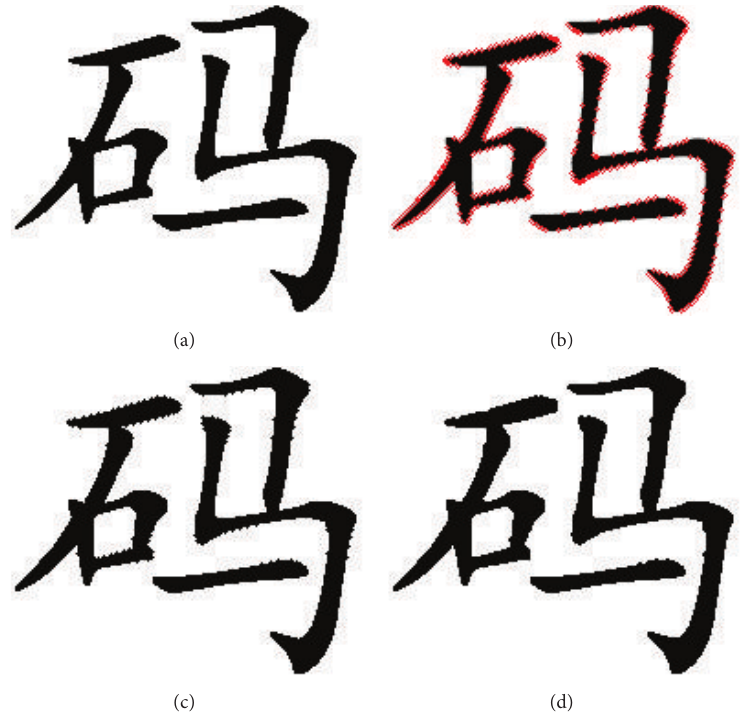
Figure 11: The application example of the proposed denoising method: (a) the original font binary image, black pixels count is 6335; (b) the position of the pixels flipping based on pixel score; the red points denote flipping position, flipping 500 pixles; (c) the image after pixels flipping; (d) the font binary image after denoising based on gravity center and chaos